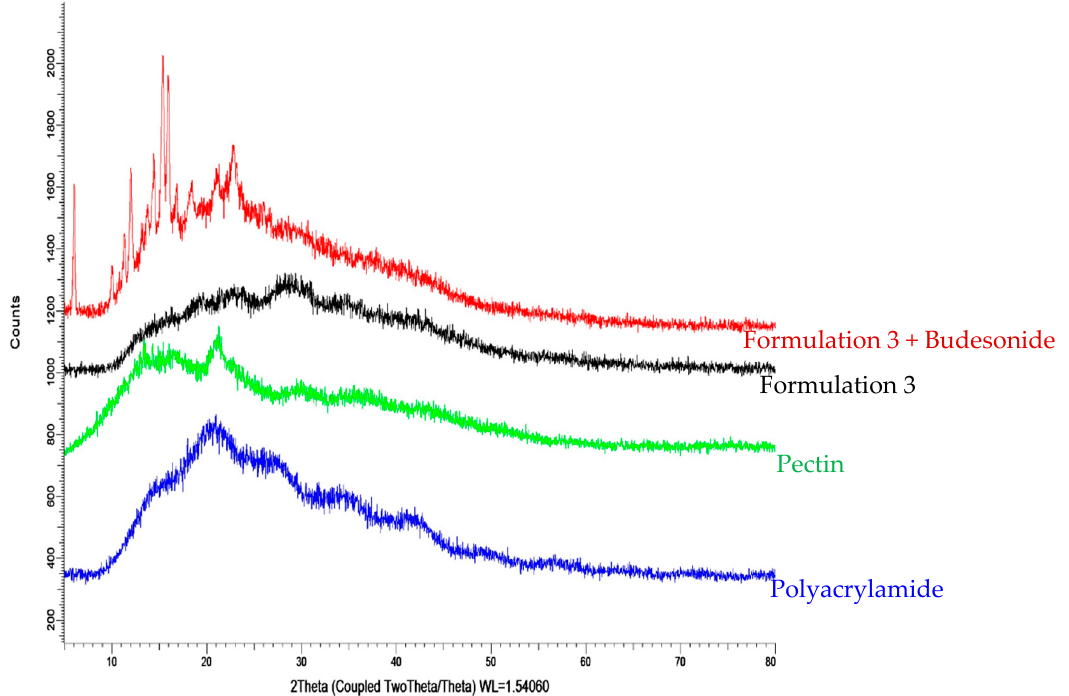
Figure 5. X-RD analysis of pectin, polyacrylamide (PAM), loaded hydrogel (Formulation 3 + drug) and unloaded hydrogel (Formulation3).